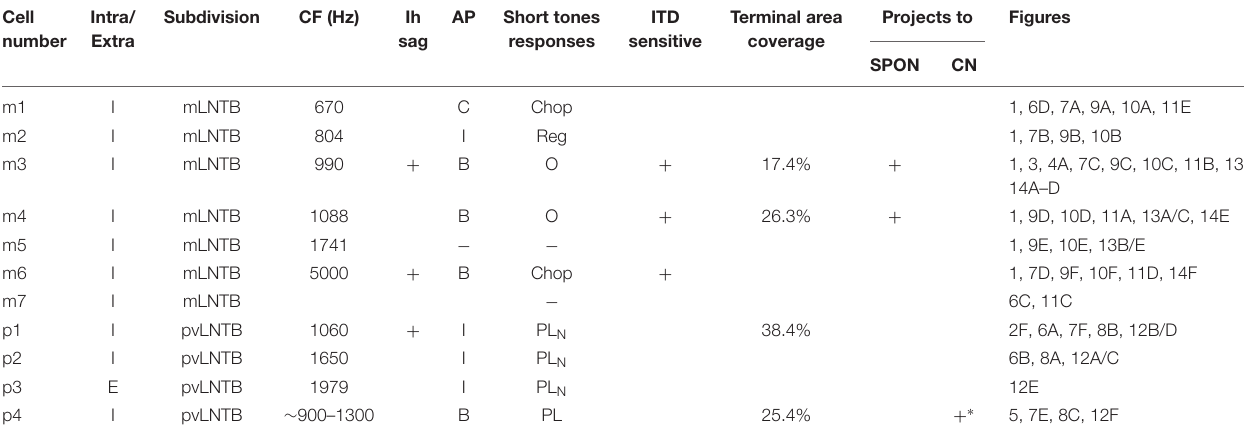
TABLE 1 | Overview of LNTB cell properties.